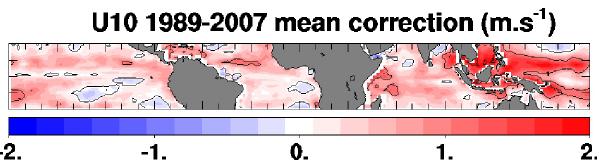
Fig. 8. 1989–2007 mean wind speed correction in the 20 ◦ N–20 ◦ S latitude band. Isocontours from − 2 to 2ms − 1 by